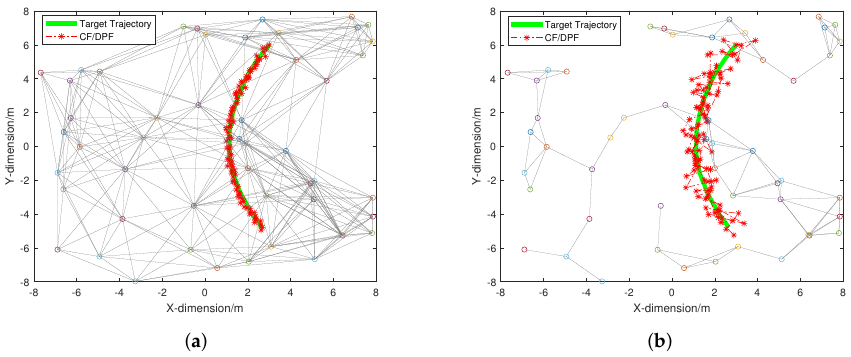
Figure 1. Tracking trajectory of CF/DPF. ( a ) Tracking trajectory in a dense network. ( b ) Tracking trajectory in a sparse and dynamic